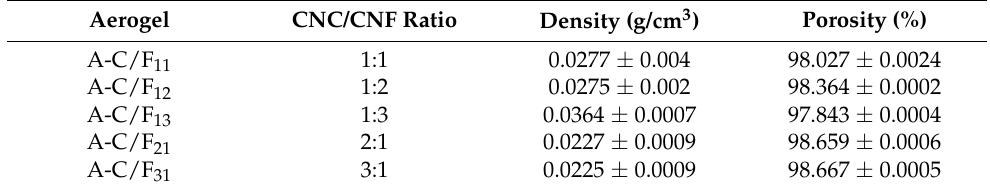
Table 1. Density and porosity of aerogel-CNC/CNF mixture in different ratios.